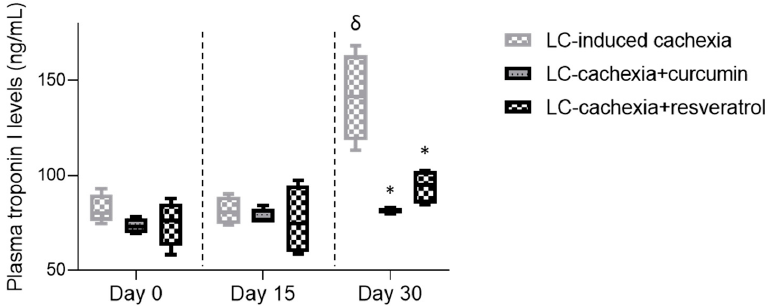
Figure 5. Representative immunoblots of actin, MyHC, and GAPDH protein content in the gastrocnemius ( A ) and soleus ( B ) muscles of all study groups of mice. Box plots of actin ( C ) and MyHC ( D ) protein content in gastrocnemius and soleus muscles of the different study groups of mice, as measured by optical densities in arbitrary units (OD, a.u.). Definition of abbreviations: a.u., arbitrary units; MW, molecular weight; kDa, kilodalton; LC, lung cancer; MyHC, myosin heavy chain; GAPDH, glyceraldehyde-3-phosphate dehydrogenase. ns, non significant.